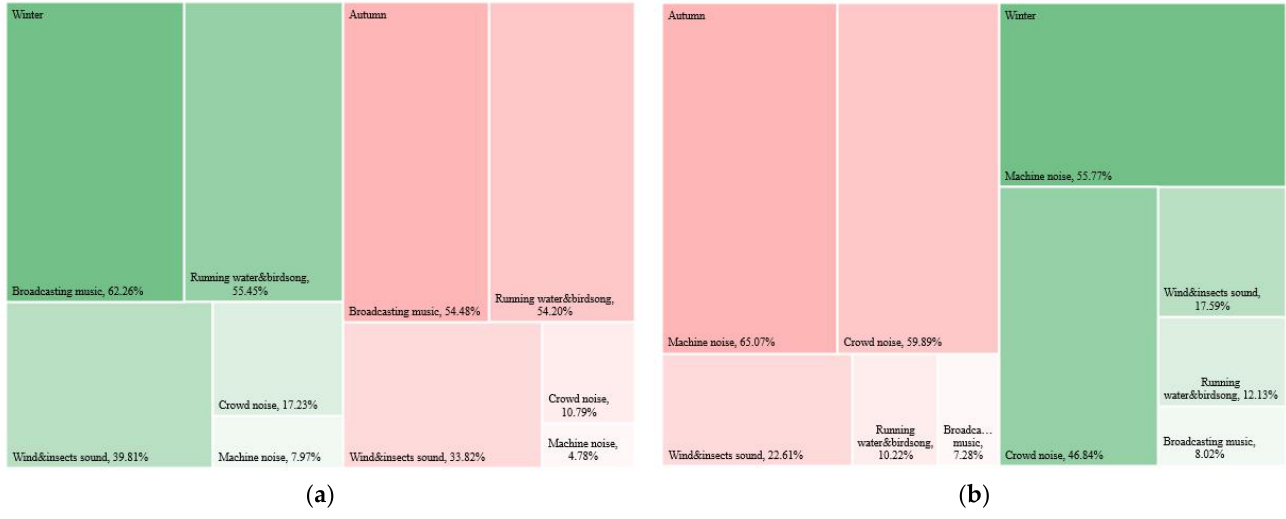
Figure 5. Proportion of positive adjectives ( a ) and negative adjectives ( b ).